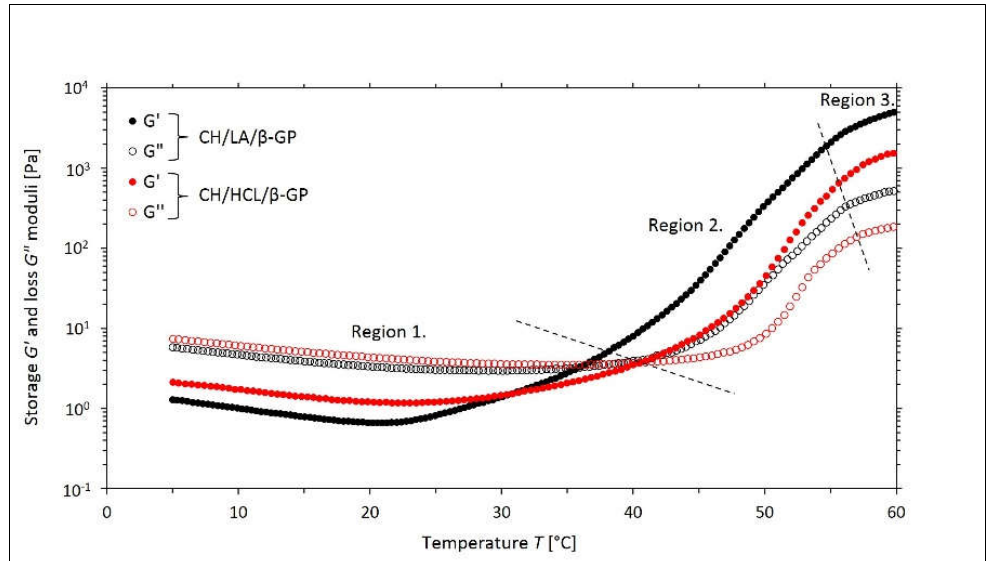
Figure 1. The experimental curves of the changes in the values of the storage G ′ and loss G ′′ moduli as a function of the temperature T obtained for the chitosan lactate solutions (the CH/LA/β-GP system) and chitosan chloride (the CH/HCL/β-GP system) with β-glycerol phosphate disodium salt pentahydrate (β-GP).